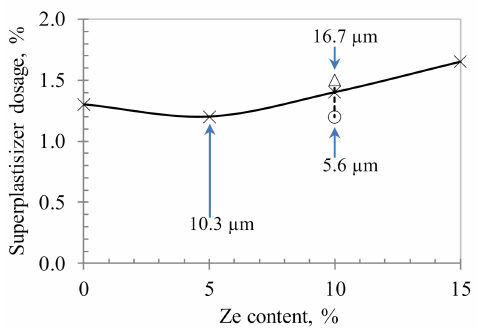
Figure 5. Relationship between the dosage of superplasticizer and the zeolite replacement for HPC mixture with water / binder ratio of 0.18 and flowability diameter ranging from 200–230 mm.